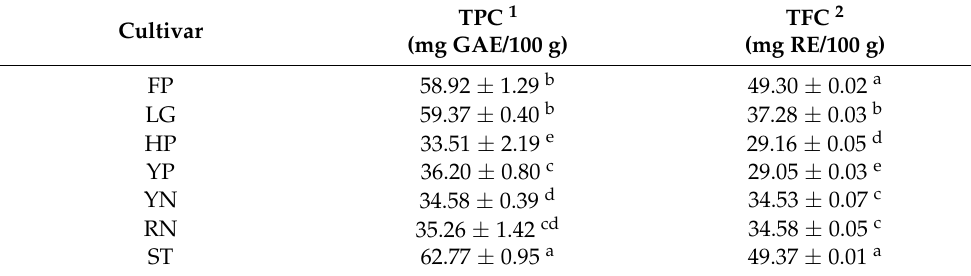
Table 2. The total phenolic and total flavonoid content of seven peach cultivars. Cultivar